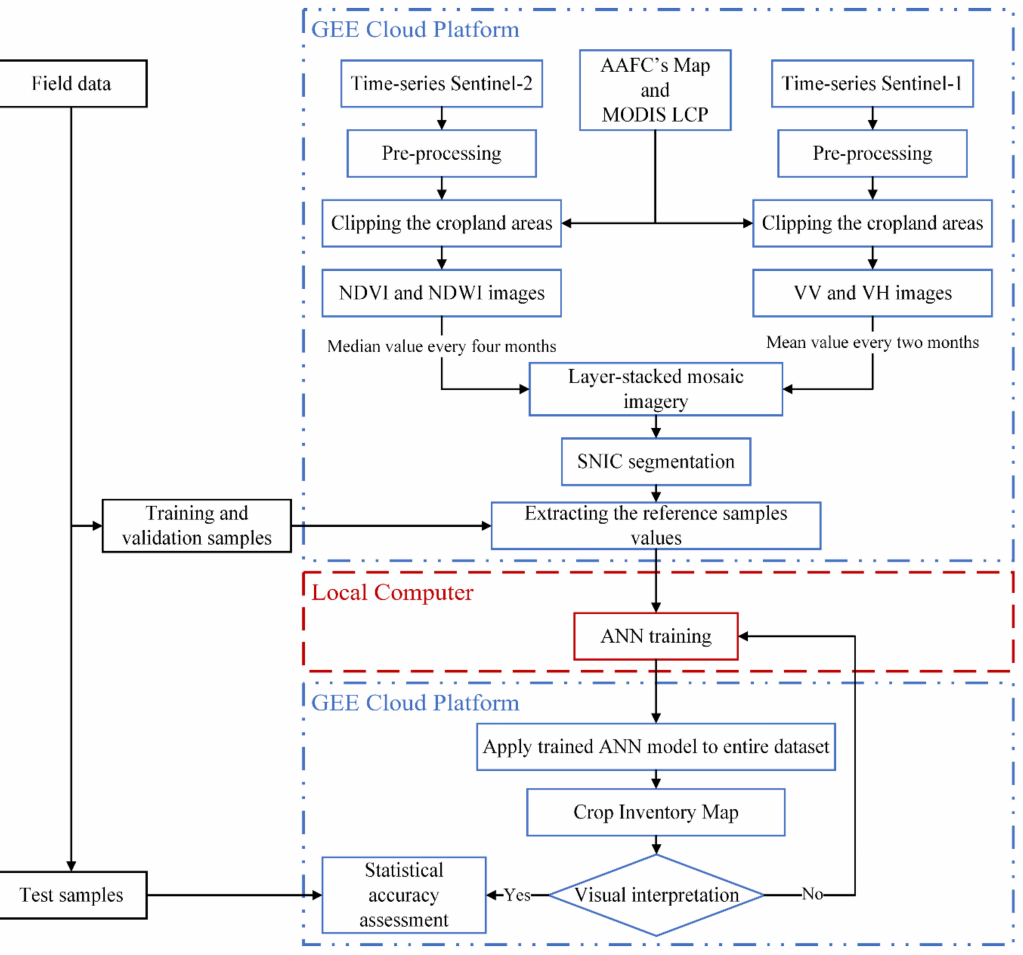
Figure 3. Flowchart of the proposed method to produce the Annual Space-Based Crop Inventory (ACI) map using Google Earth Engine (GEE) and Artificial Neural Network (ANN) algorithm (AAFC: Di ff erence Water Index, SNIC: Simple Non-Iterative Clustering, MODIS LCP: Moderate Resolution Imaging Spectroradiometer Land Cover